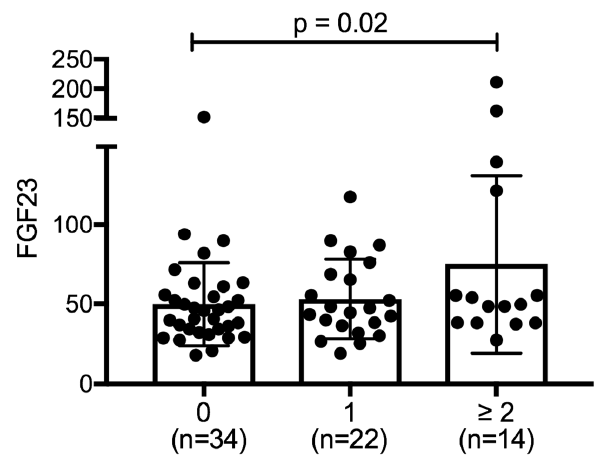
Figure 1. Fibroblast Growth Factor (FGF) 23 levels across chronic obstructive pulmonary disease (COPD) exacerbation frequency sub-groups. Box and dot plot indicating FGF23 plasma level means